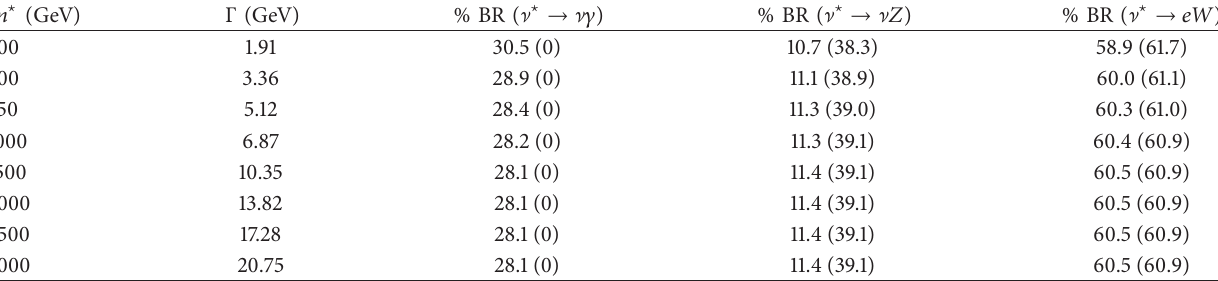
Table 1: Branching ratios and total decay width of excited spin-1/2 neutrinos for 𝑓 = −𝑓 󸀠 = 1 (𝑓 = 𝑓 󸀠 = 1) . Here it is taken as Λ = 𝑚 ⋆ . 𝑚 ⋆ ( GeV